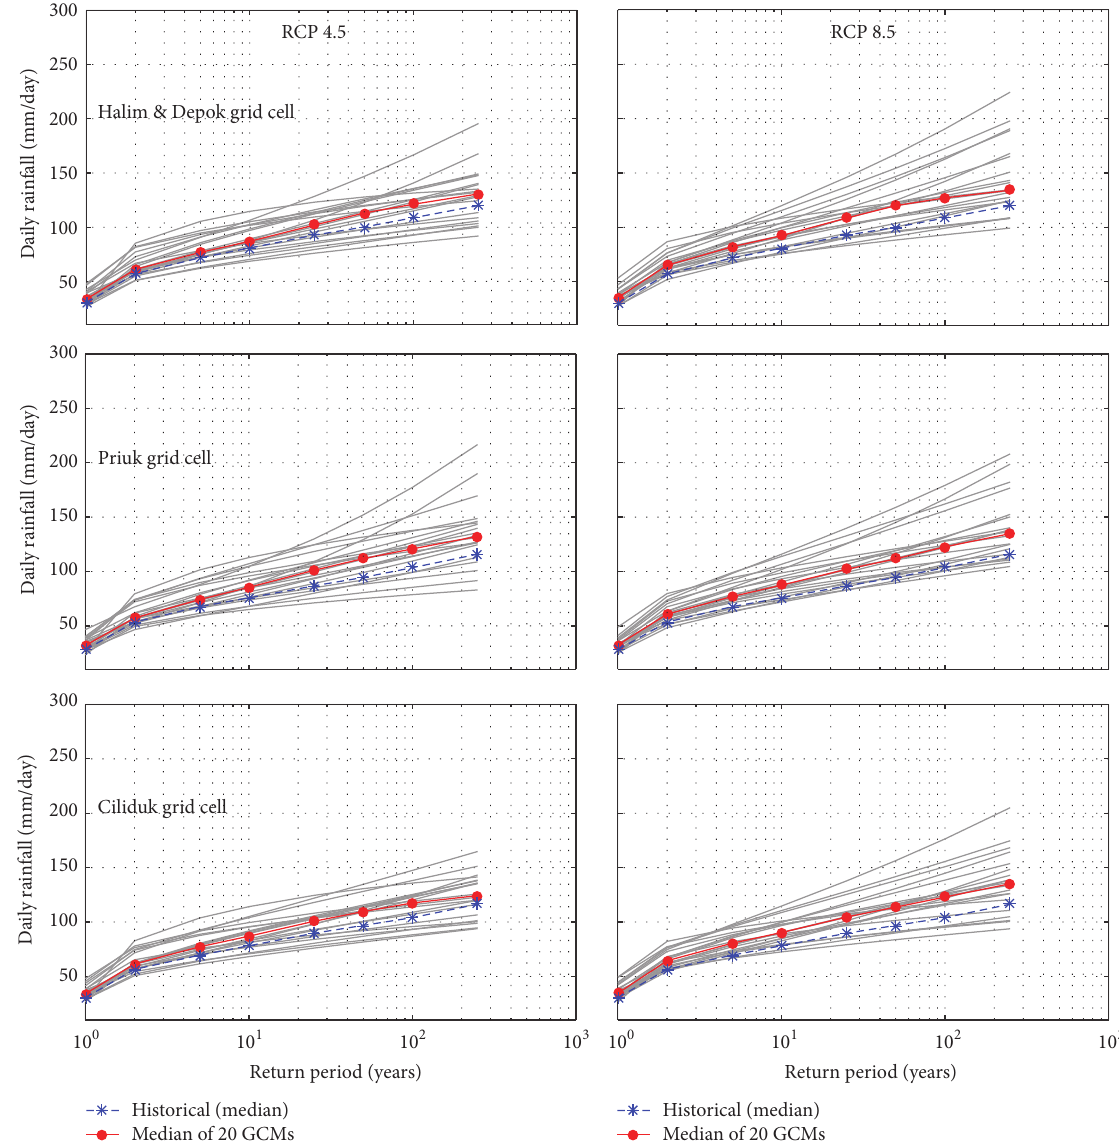
Figure 10: Comparison of median historical and median future predictions with 20 GCMs and RCP 4.5 and 8.5 in 0.25 ∘ × 0.25 ∘ grid cells. The 20 GCM predictions are indicated with thick grey lines. Stations Halim and Depok lie in a single grid cell.